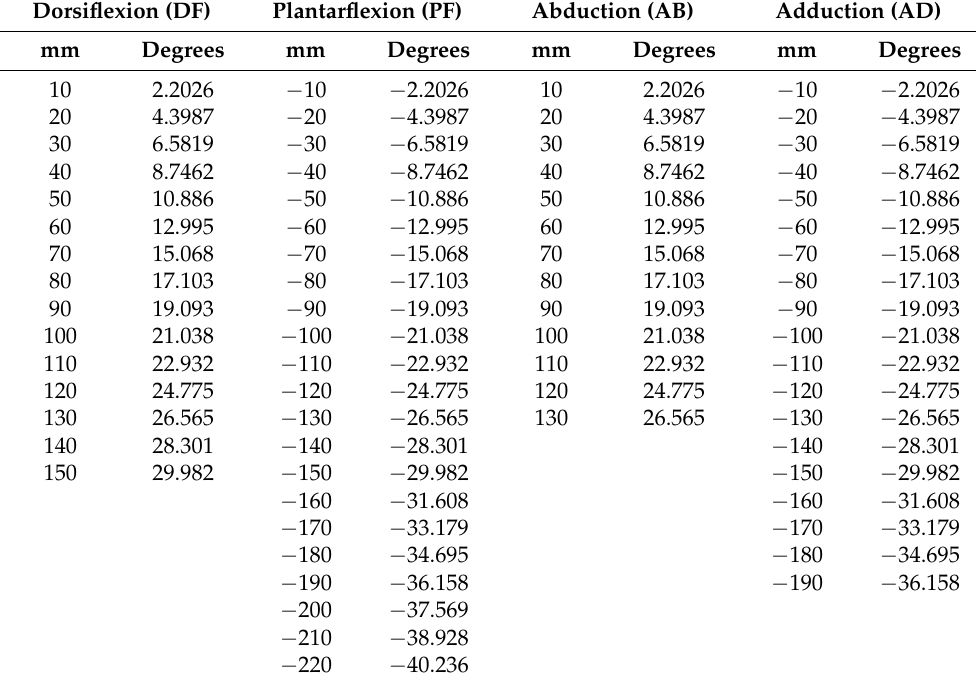
Table 6. Relation between the displacement of the linear guide vs angle movement.